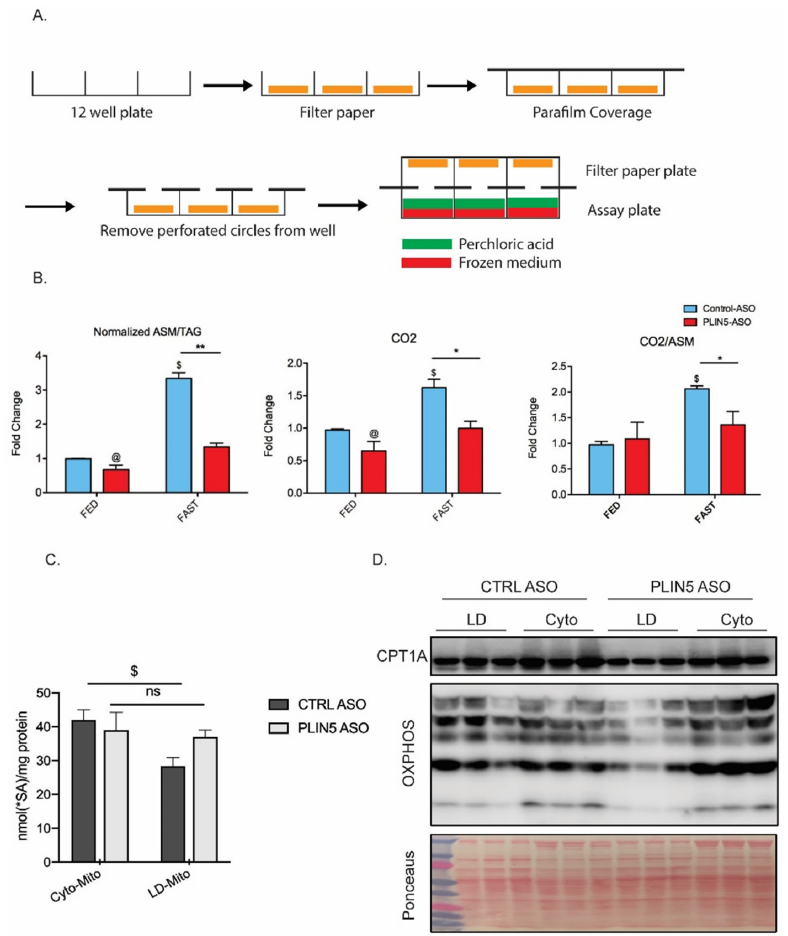
Figure 4. PLIN5 negates oxidative capacity differences in peri-droplet and cytosolic mitochondria. ( A ) Preparation of the Filter Plate. Place one piece of filter paper on the bottom of each well of the 12-well sterile plate and overlay the plate with a piece of parafilm. Then, use a large rectangular object to rub the parafilm on the wells to perforate the parafilm at the well openings and form a seal over the remainder of the plate. Finally, remove the perforated circles of parafilm now covering the wells. ( B ) The ratio of normalized ASM to TAG, CO 2 , and the ratio of CO 2 to ASM from primary hepatocytes incubated under the condition of FED or FAST. ( C ) FA oxidation as measured by ASM production. ( D ) Western blot analysis of CPT1A and OXPHOS protein levels in LD-Mito and Cyto- Mito in liver tissue from FED and FAST 16 h of each group. @ p < 0.05 vs. FED-CTRL ASO. * p < 0.05, ** p < 0.01 vs. FAST-CTRL ASO. $ p < 0.05 vs. Cyto-Mito.